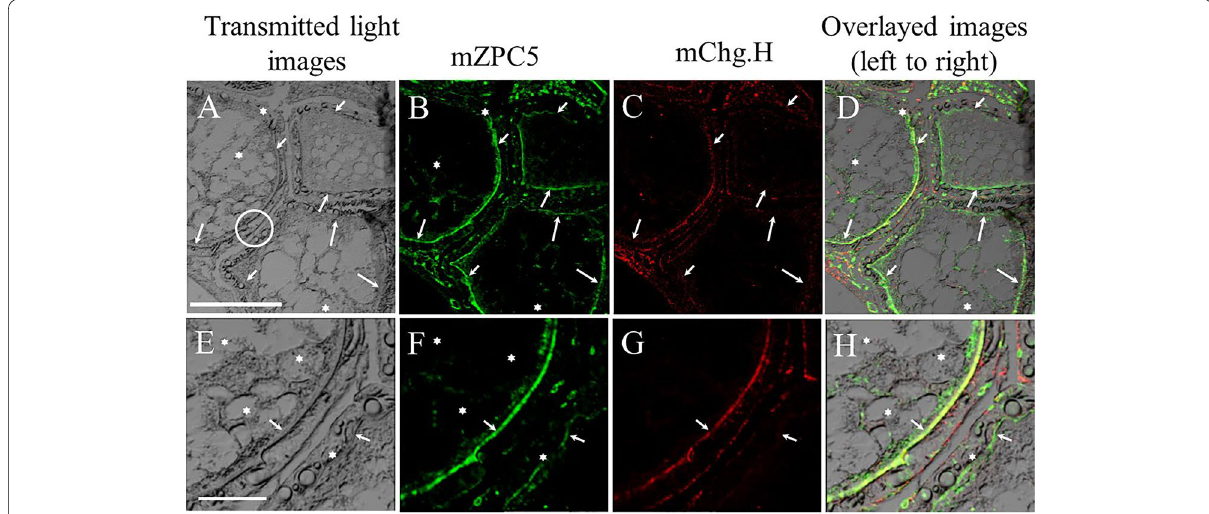
Fig. 8 Immunohistochemical detection of mZPC5 in a chg.l-/- female ovary. 8A and 8E : Transmitted light image of an ovarian oocyte in the ovary of a sexually mature female. 8B and 8F : The same ovarian oocytes shown in 8A and E, respectively, but with highlighted issue regions immunoreactive to anti-mZPC5 antibodies. 8C and 8G : The same ovarian oocytes shown in 8A and 8E , respectively, but with highlighted issue regions immunoreactive to anti-Chg.H antibodies. 8D : Transmitted light image 8A overlaid with 8B and 8C . 8H : Transmitted light image 8E overlaid with 8F and 8G . White arrows: position of the chorion. It should be noted that 8E to 8H show magnifications of the white-circled area in 8A . Symbols – white stars: the location of ZPC5 in the ooplasm. Scale bars in 8A and 8E represent 100 and 20 µm, respectively. The developing stage of the oocytes was determined following Iwamatsu et al. 1988